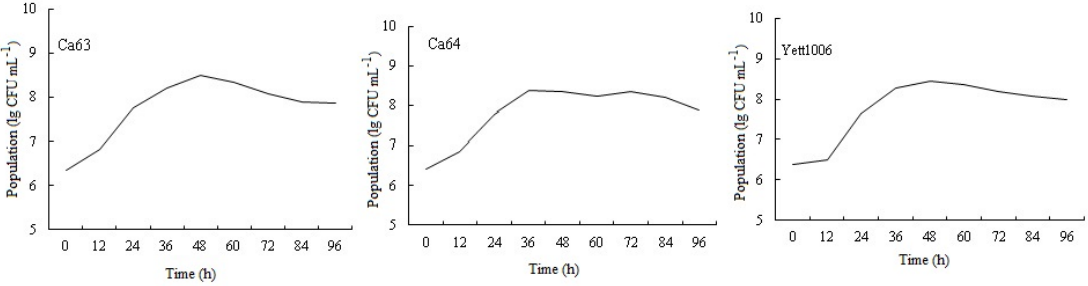
Figure 4. Growth dynamics of three yeast strains on the surface of snap beans. Storage Tests of Postharvest Snap Beans